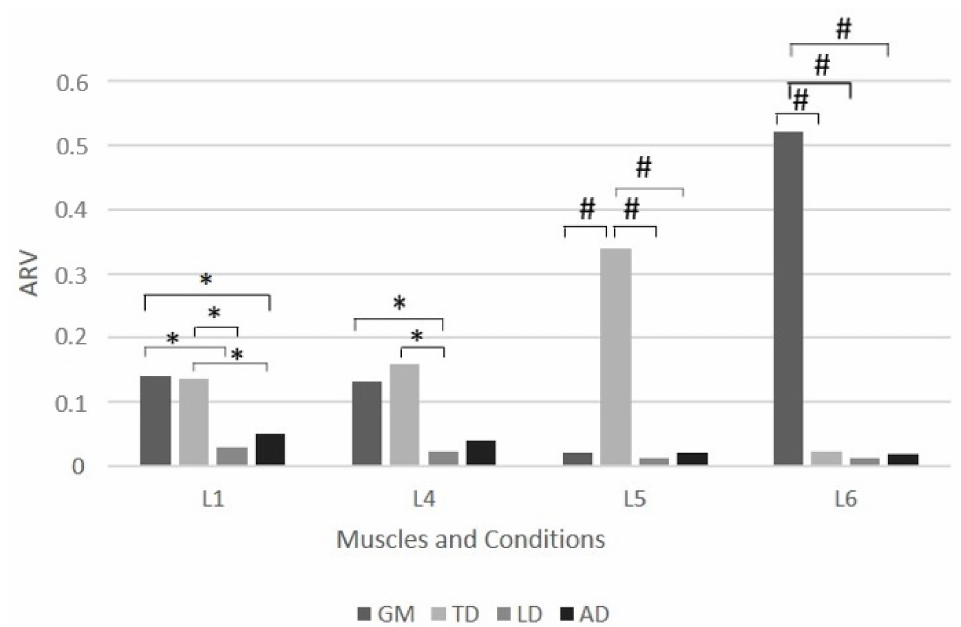
Figure 1. Differences between muscles according to ARV electromyographic activity (Tukey’s post- hoc test) in the different cycling conditions using a long bicycle frame. Differences between muscles for L1 (maximal intensity with high handlebars), L4 (maximal intensity with low handlebars), L5 (150 watts of intensity with low handlebars), and L6 (250 watts of intensity with low handle- bars) conditions using a long bicycle frame. TD—trapezius descending; LD—latissimus dorsi; GM—gluteus maximus; AD—anterior deltoid. * Significance for p < 0.05; # Significance for p < 0.001.